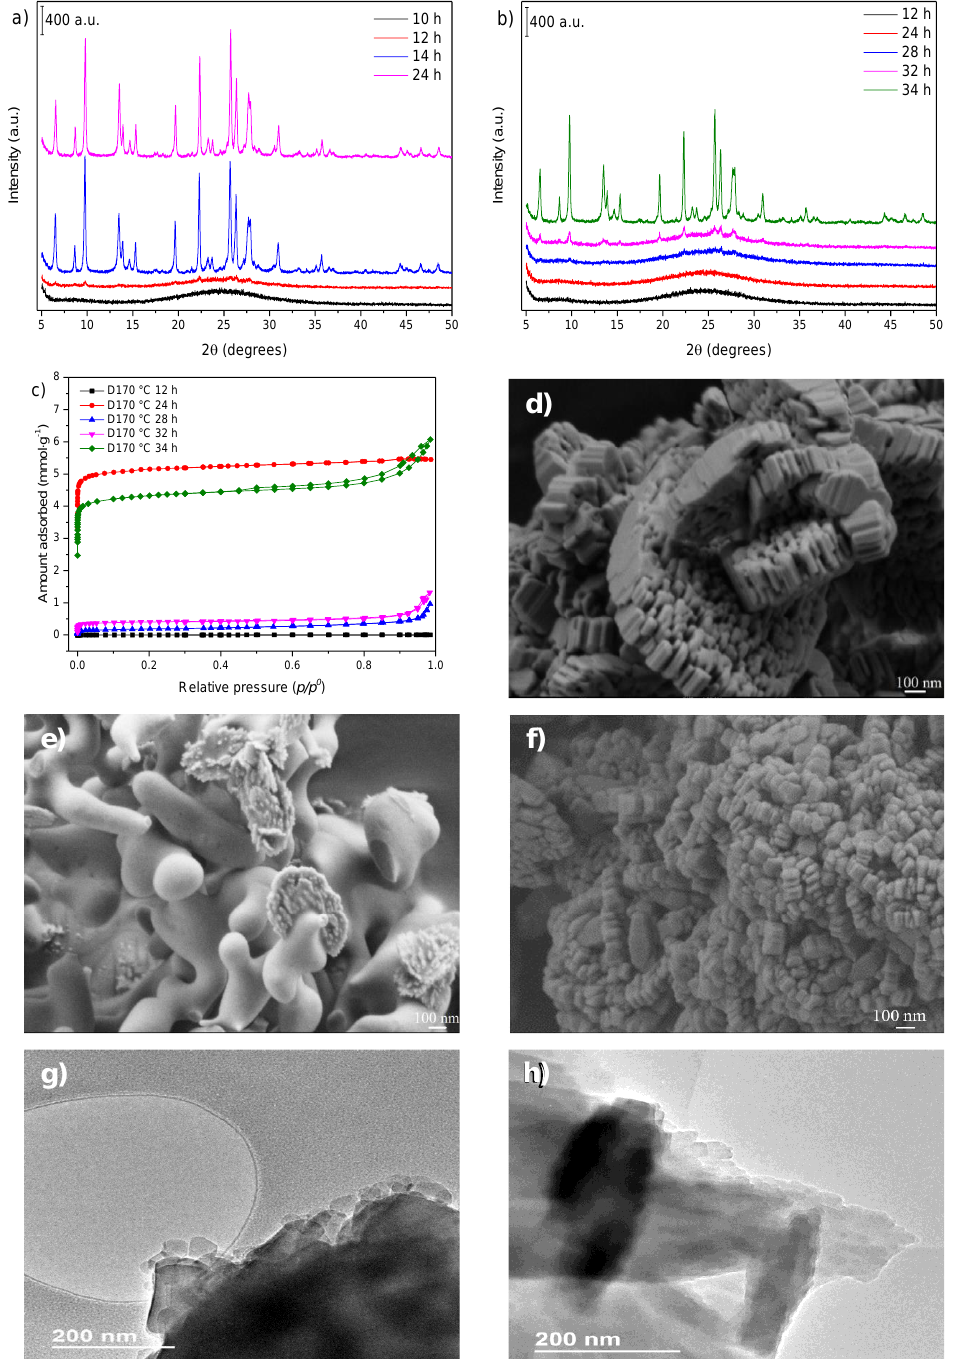
Figure 4. Comparison of crystallization kinetics for diluted gels. XRD patterns of samples obtained at ( a ) 170 ◦ C and ( b ) 150 ◦ C; ( c ) N 2 adsorption–desorption isotherms; SEM images of samples prepared at ( d ) 170 ◦ C for 24 h, ( e ) 150 ◦ C for 28 h, and ( f ) 150 ◦ C for 34 h; TEM images of samples synthesized at ( g ) 170 ◦ C for 24 h and ( h ) 150 ◦ C for 34